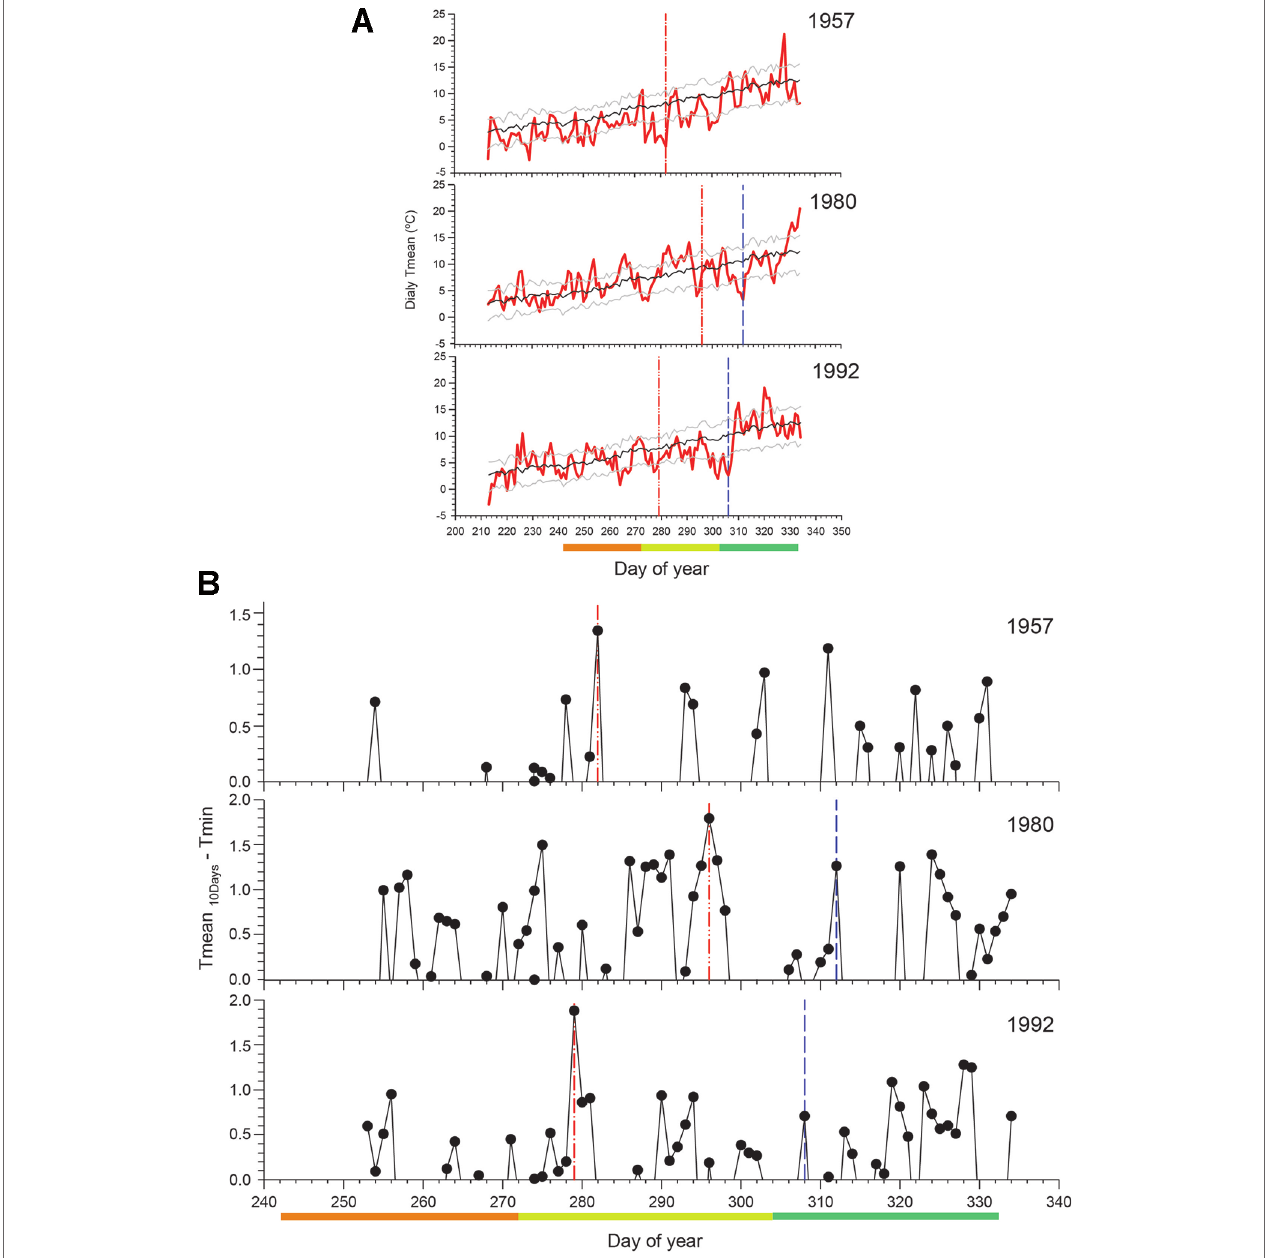
FIGURe 6 | (A) Daily mean temperature in three selected years with low uncertainty (1957) or validated (1980 and 1992) spring frosts in the Bariloche region. The black line shows the mean in the reference period, and the grey lines the standard deviation. (B) Mean temperature in the previous 10 days minus the absolute minimum temperatures in that day. High values of this index indicate warm temperatures followed by extreme minimum temperatures (below zero), and thus a high probability of frost event occurrence (red line). The blue line indicates the known date of frost damage in agricultural records. The orange, yellow, and green bars indicate September, October, and November, respectively